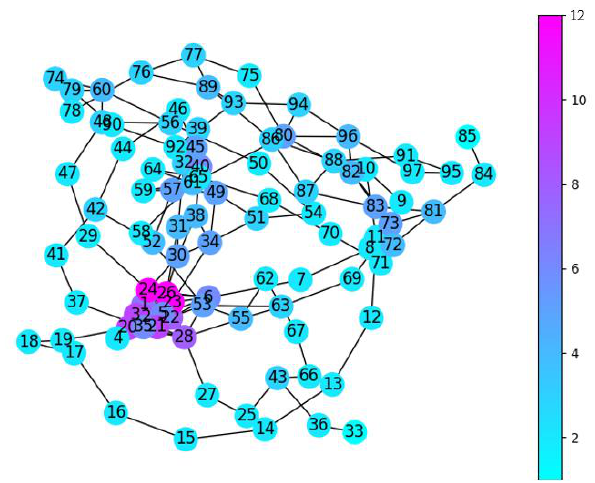
Figure 2. Distribution of node degree values of complex traffic networks.